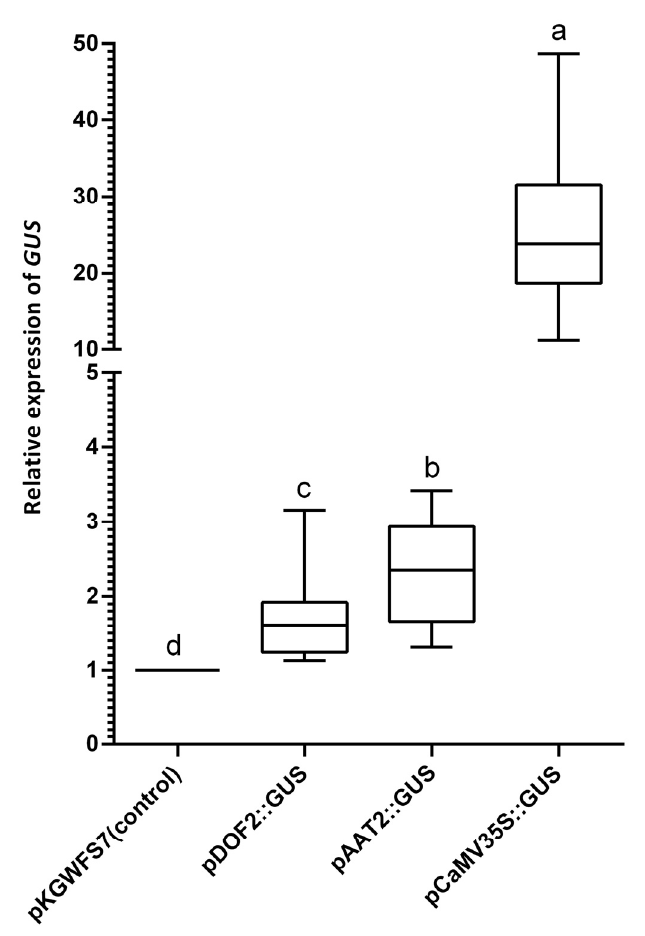
Figure 5. Quantitative real-time RT-qPCR expression analysis of GUS transcript levels in strawberry fruit transiently agroinfiltrated with the different promoter probe constructs. Box-plot graphs represent the distribution of gene expression values as relative GUS expression to the pKGWFS7 empty vector (negative control). Horizontal lines in the box indicate the median (Q2) and box the inter quartile range (Q3 Q1). Letters “a”, “b”, “c”, and “d” indicate statistically significant differences among samples, ( p < 0.01, Wilcoxon–Mann–Whitney